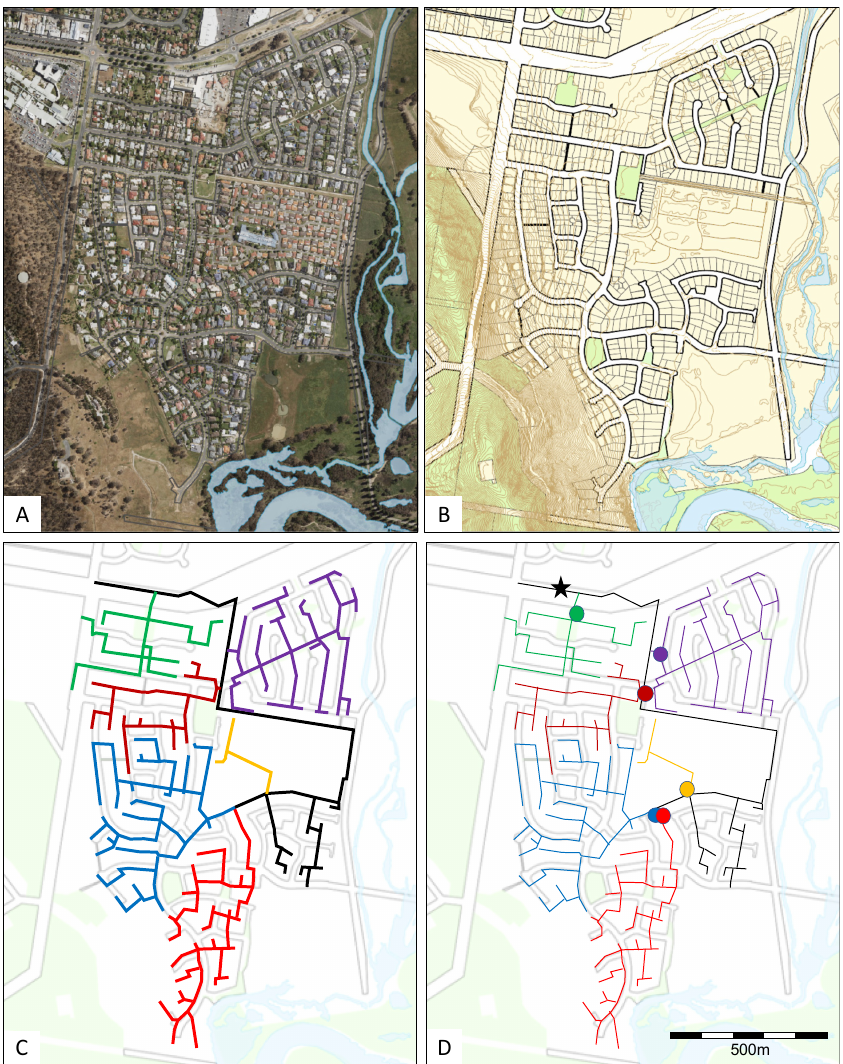
Figure 2. Conceptual example of retrofitting stratified sampling points to an existing development in Albury, NSW, Australia. ( A ) Aerial image; ( B ) street and contour map; ( C ) existing sewerage net-work color coded to show subnetworks; ( D ) suggested interception and sampling points (aerial photograph, base map and sewer alignment based on data derived from the Albury City Mapping Portal).